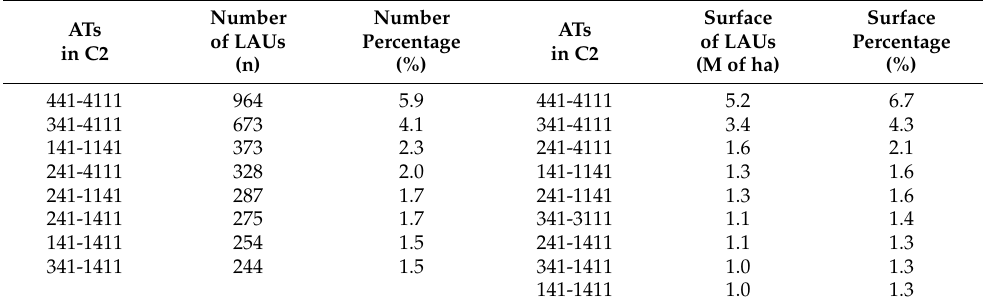
Table 5. The most representative agricultural typology (AT) identified for the second census date (C2) in terms of number of LAUs (>%1 of the total number) and surface of LAUs (>1 M of ha). Surface Number Number ATs ATs of LAUs of LAUs Percentage in C2 in C2 (M of ha) (n) (%)